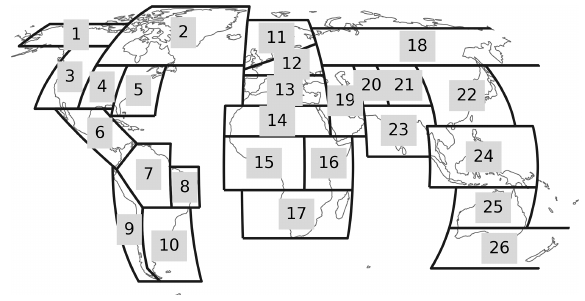
Figure B2. The Intergovernmental Panel on Climate Change (IPCC) Special Report on Extremes (SREX) regions (Seneviratne et al., 2012), which were used in the figures (Figs. 6, B6, and B9–B11) to spatially average the global terrestrial water storage interannual variability time series into four selected regions. These include the Laurentian Great Lakes (SREX regions 5), the Amazon (SREX regions 7), eastern and western Africa (SREX regions 15 and 16), and South Asia (SREX regions